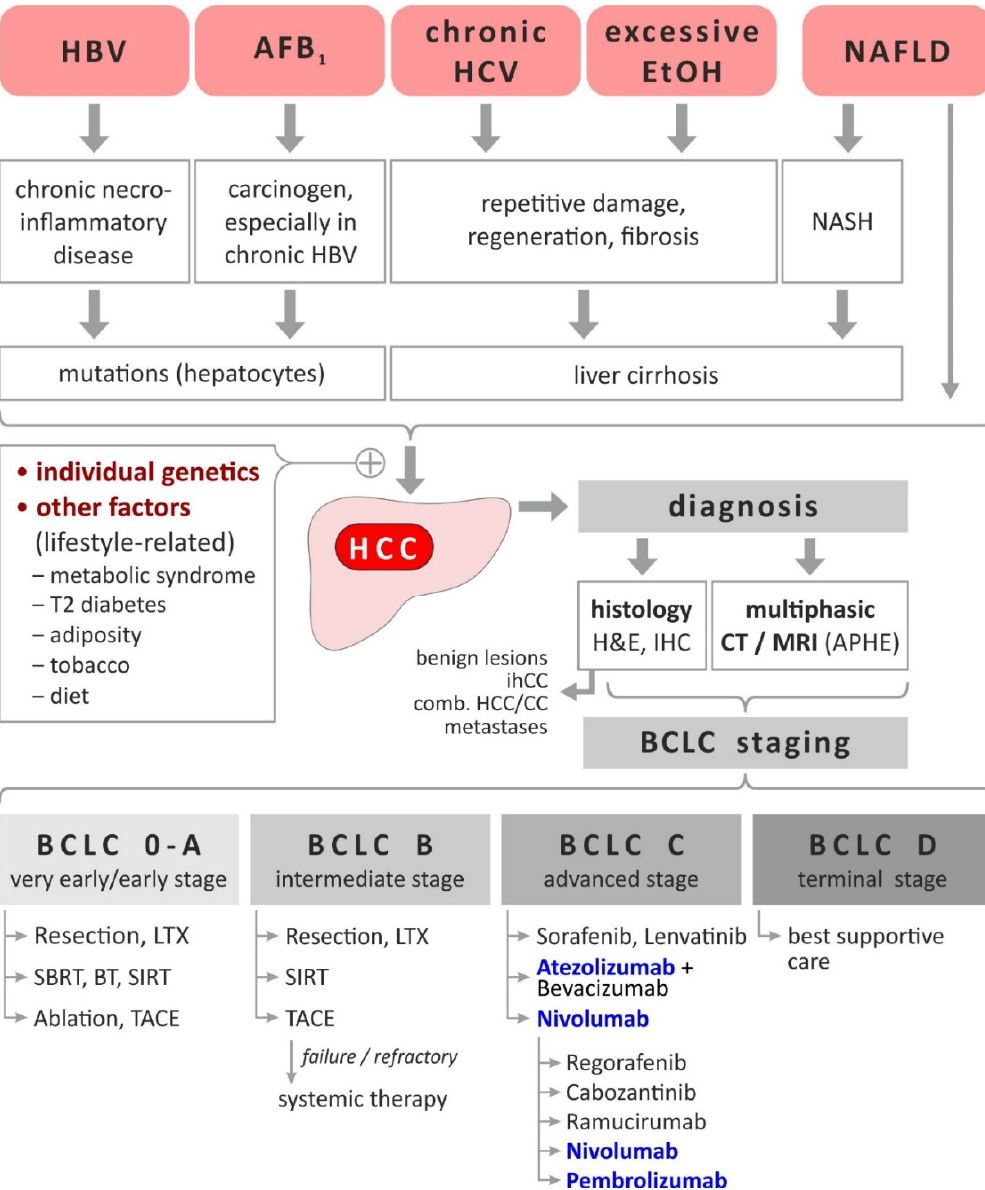
Figure 1. HCC-Etiology, risk factors, diagnosis and staging-dependent current treatment. Based on [3,5,8,15] . Immunomodulatory treatments are highlighted bold and blue. Abbreviations: AFB 1 , aflatoxin B 1 ; APHE, arterial phase hyperenhancement; BCLC, Barcelona Clinic Liver Cancer; BT, brachytherapy; CT, computed tomography; EtOH, ethanol; H(B/C)V, hepatitis B/C virus; H & E, hematoxylin & eosin; HCC, hepatocellular carcinoma; (ih)CC), (intrahepatic) cholangiocarcinoma; IHC, immunohistochemistry; LTX, liver transplantation; MRI, magnetic resonance imaging; NAFLD, nonalcoholic fatty liver disease; NASH, nonalcoholic steatohepatitis; SBRT, stereotactic body radiotherapy; SIRT, selective internal radiotherapy; T2 diabetes, type 2 diabetes; TACE, transarterial chemoembolisation.